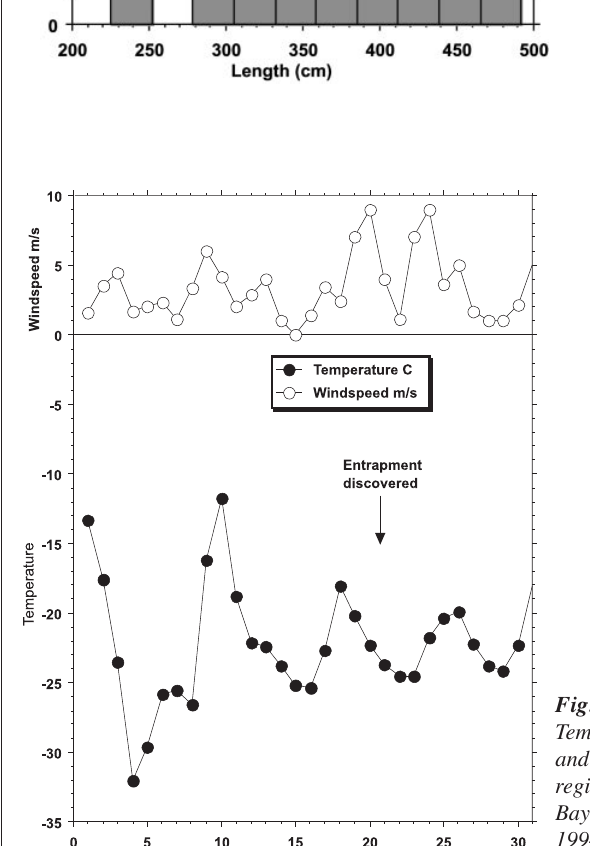
Temperature and wind speed regime in Disko Bay in March 1994 prior to the